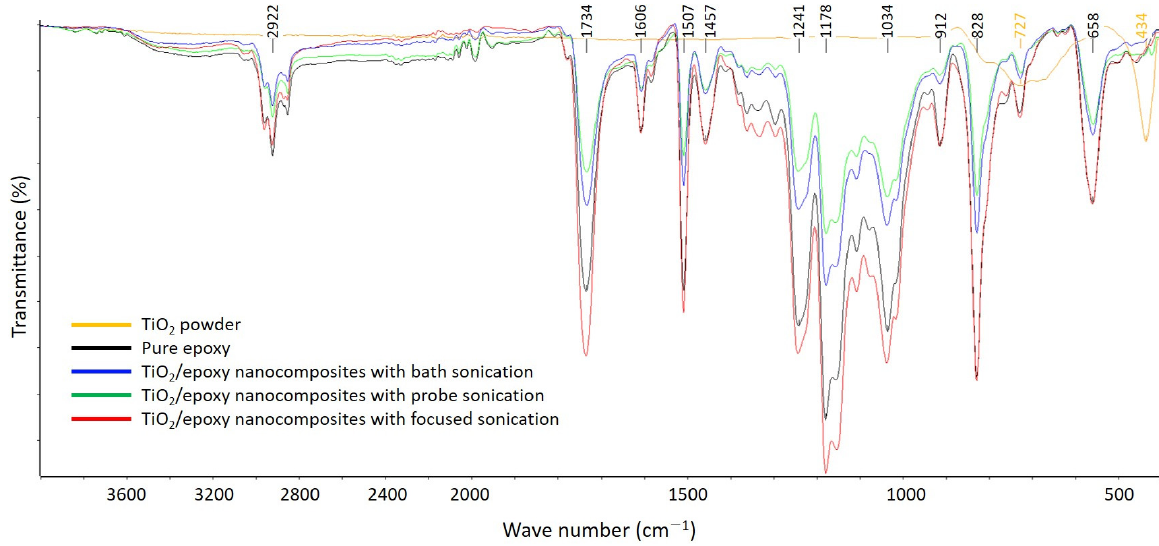
Figure 9. FT-IR spectra of the TiO 2 powder, pure epoxy resin, and the 1.0 wt.% TiO 2 –epoxy nanocomposites.